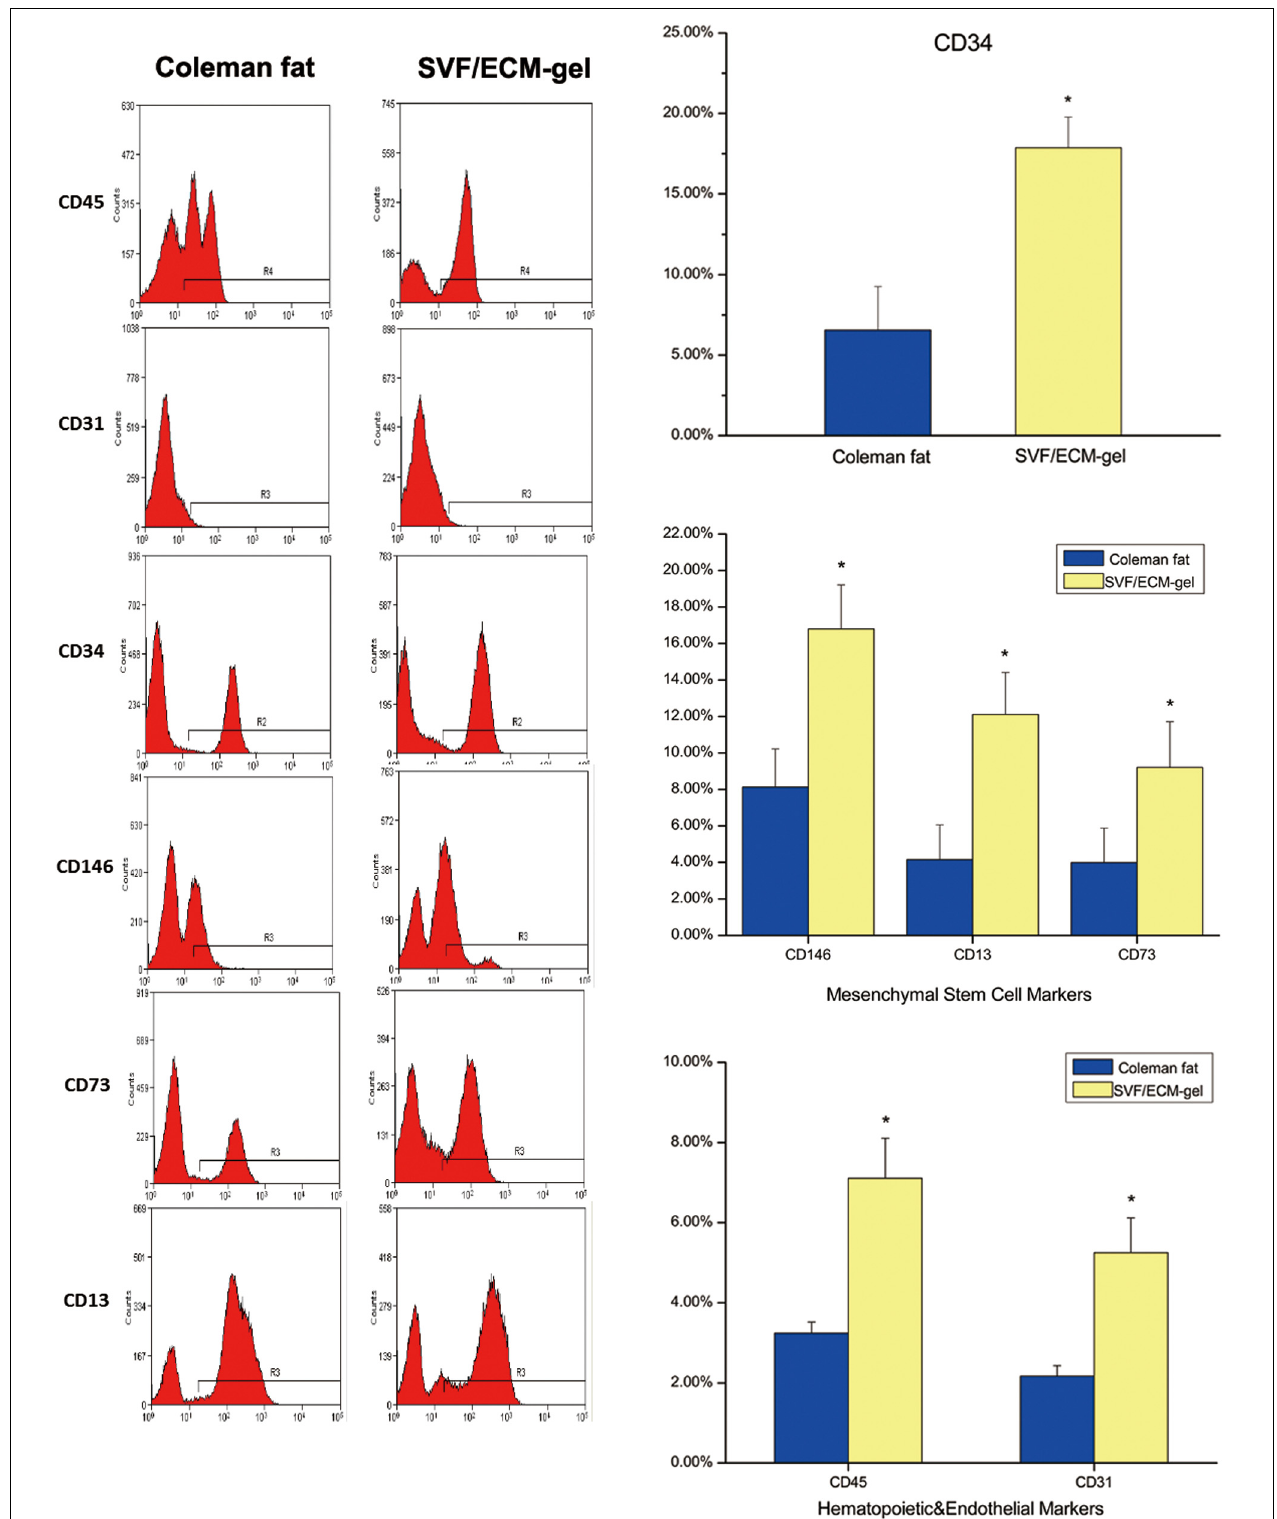
FIGURE 7 | Flow cytometry for cell surface markers of SVF cells from the two fat types. The oscillogram represents the phenotypes of SVF cells isolated from the Coleman fat group (left) and SVF/ECM gel group (right) . * P < 0.05.